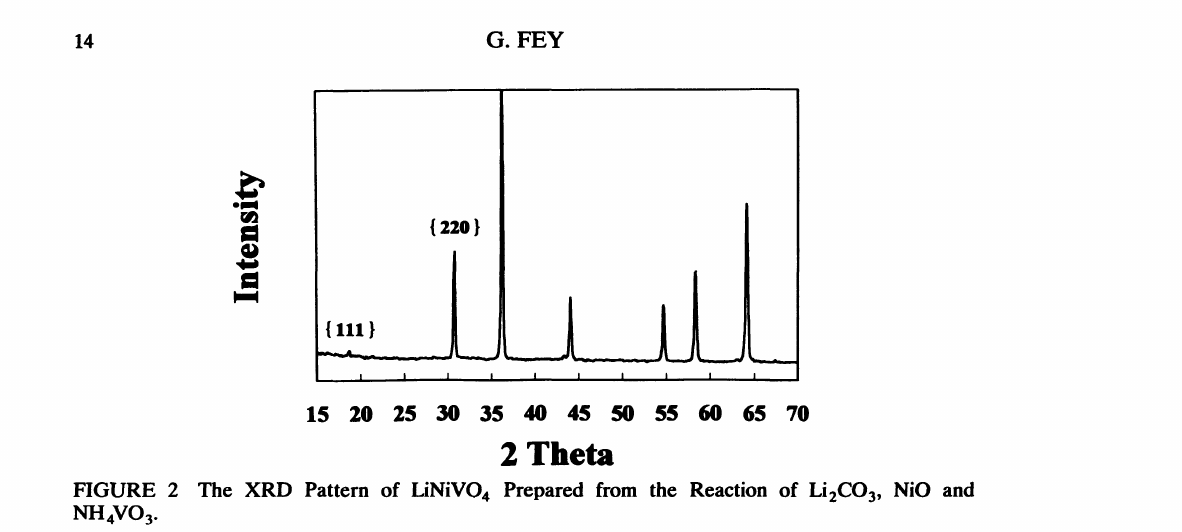
FIGURE 2 The XRD Pattern of LiNiVO4 Prepared from the Reaction of Li2CO3, NiO and NI-I